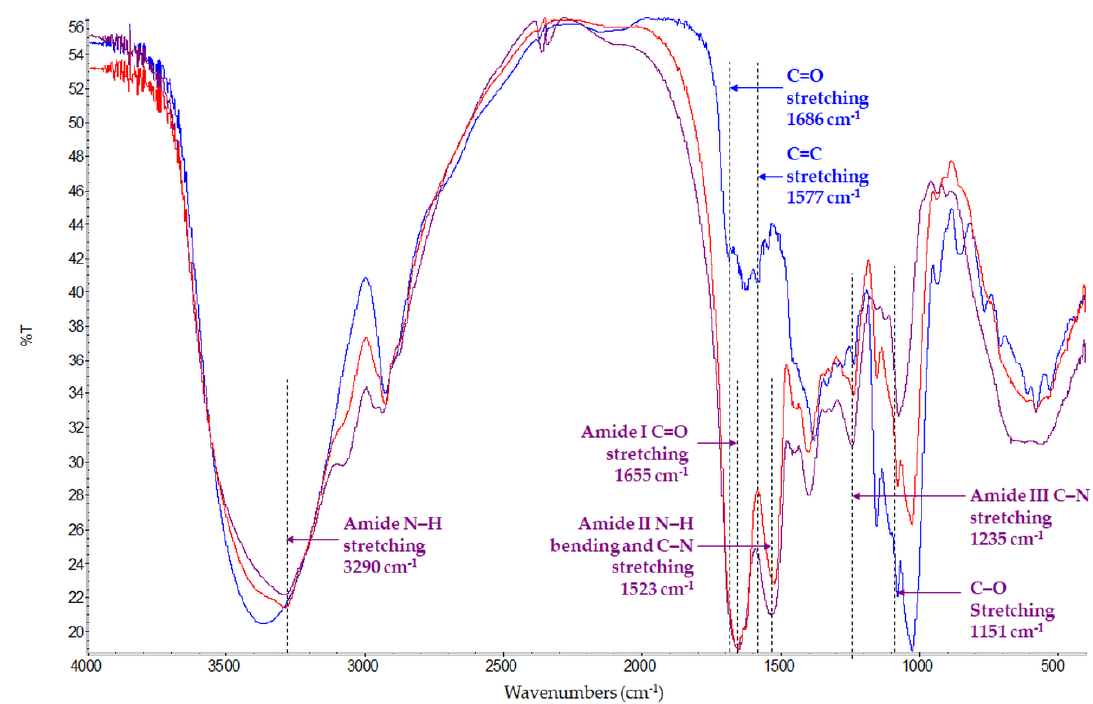
Figure 3. FT ‐ IR spectra of NPc (red line), crocetin (blue line), and sericin (purple line).